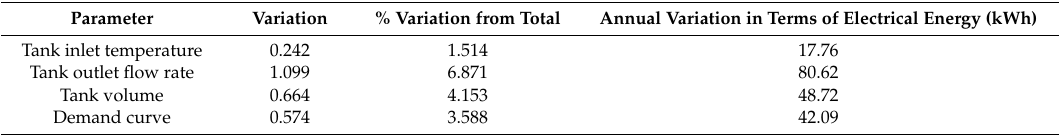
Table 4. Results